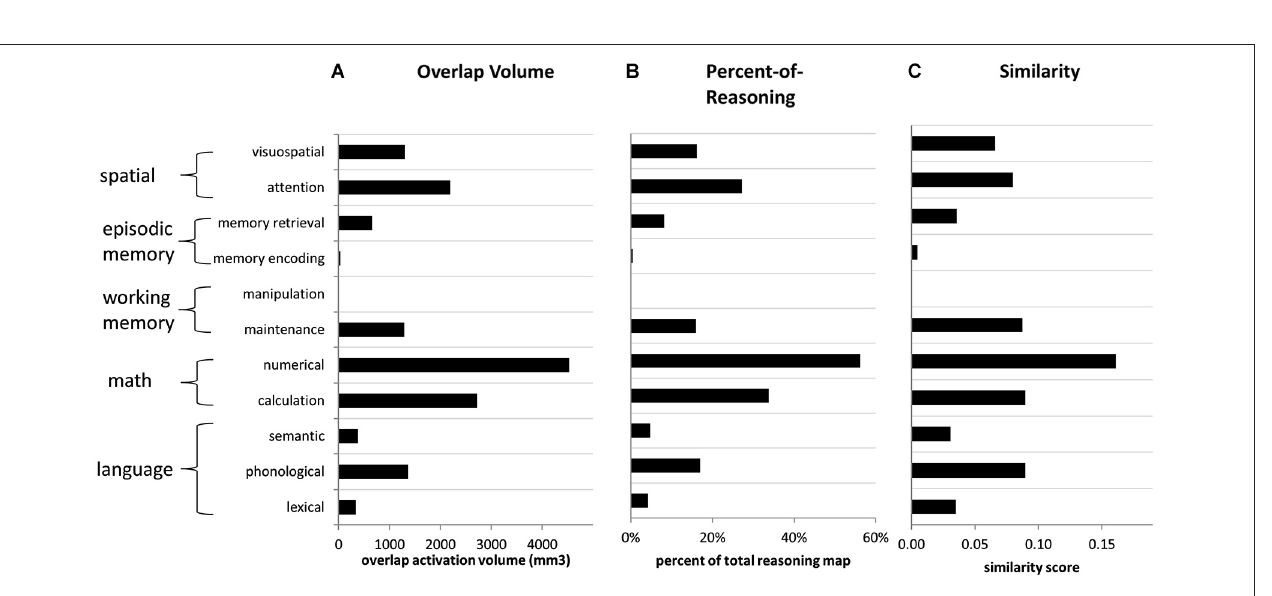
FIGURE 5 | Overlap metrics for reasoning (forward inference map) in relation to other functions (reverse inference maps). (A) Volume of overlap with the reasoning map, for the activation maps associated with each other term. (B) Percent of reasoning activation from the reasoning map that